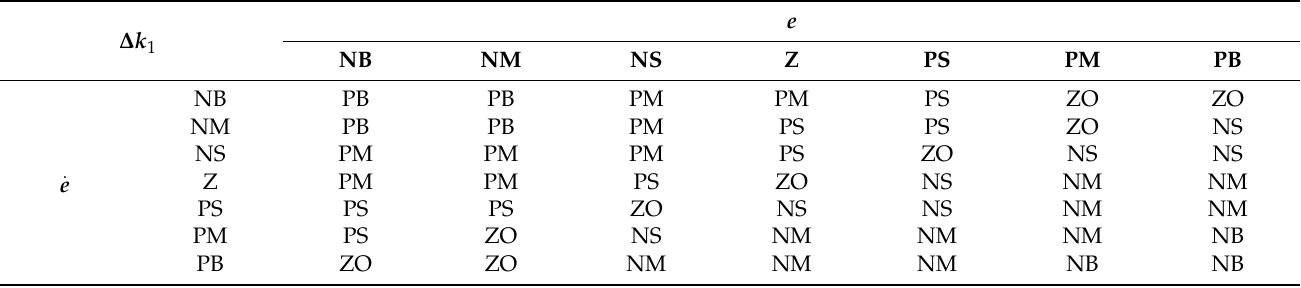
Table 2. The adjustment rules for k 1 .